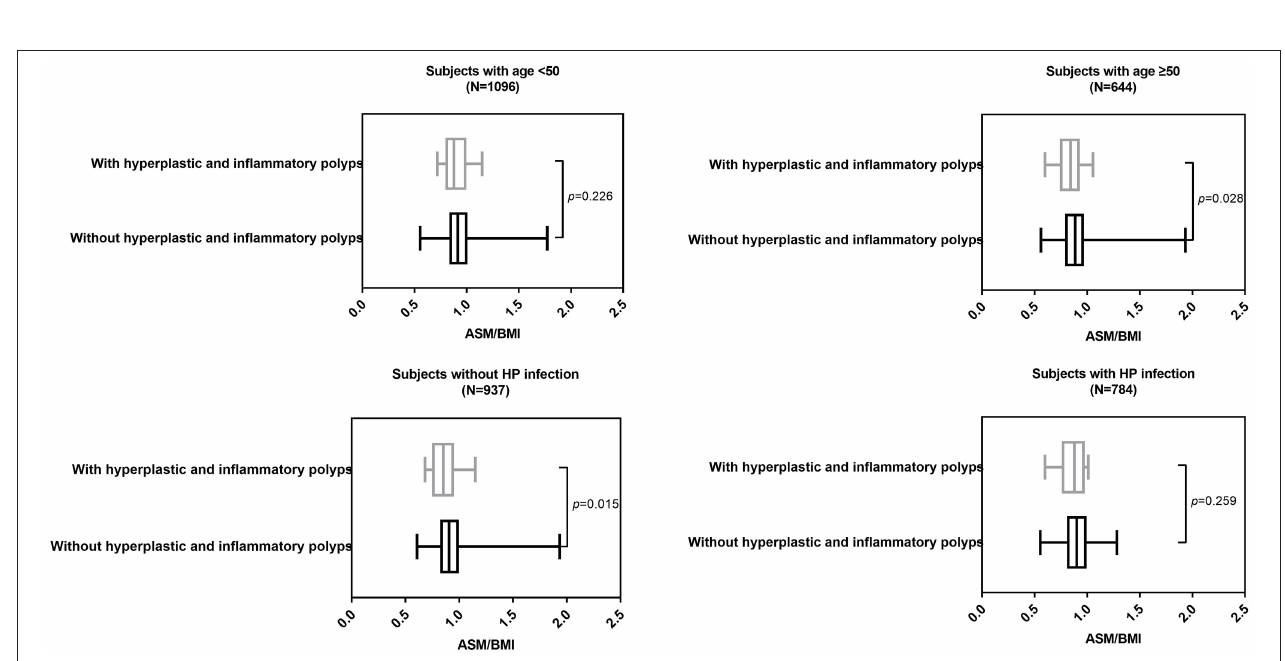
FIGURE 3 | ASM/BMI of individuals with and without hyperplastic and inflammatory polyps in different subgroups.